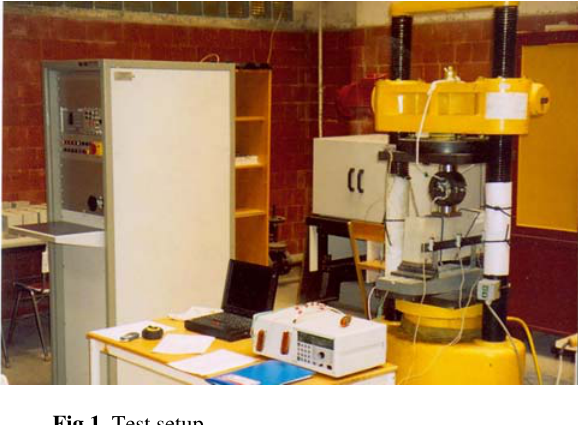
Fig 1. Test setup In the tests reported, fibre type MPZ50/1, Art.